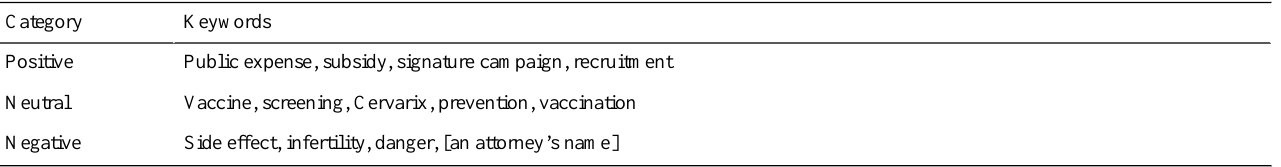
Table 1. Classification of keywords associated with human papillomavirus (HPV) in Japan.